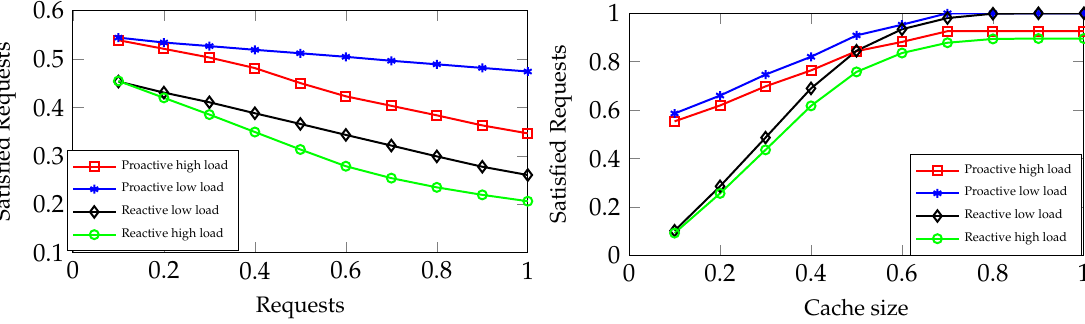
Figure 5. Proactive vs. Reactive caching showing satisfied requests vs. no. of requests ( left ) and cache size ( right ).